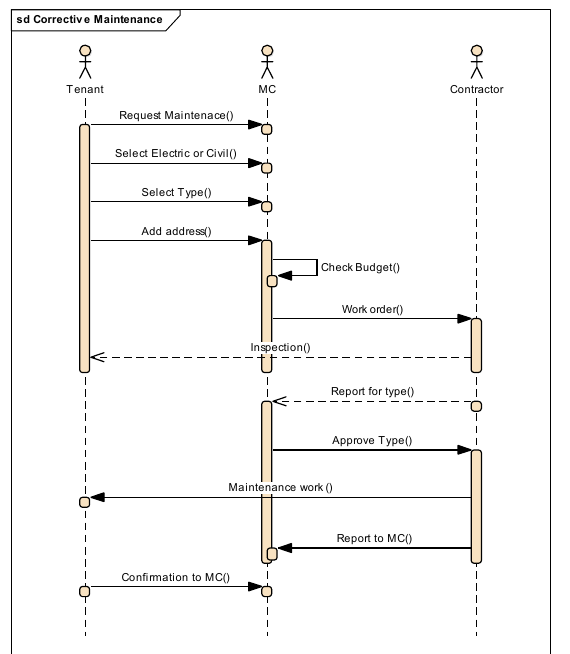
Figure 6. Sequence Diagram for Corrective Maintenance